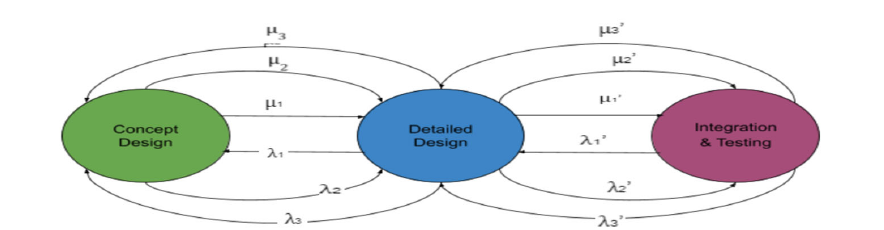
Fig. 2. Transition diagram of initial stages of new product